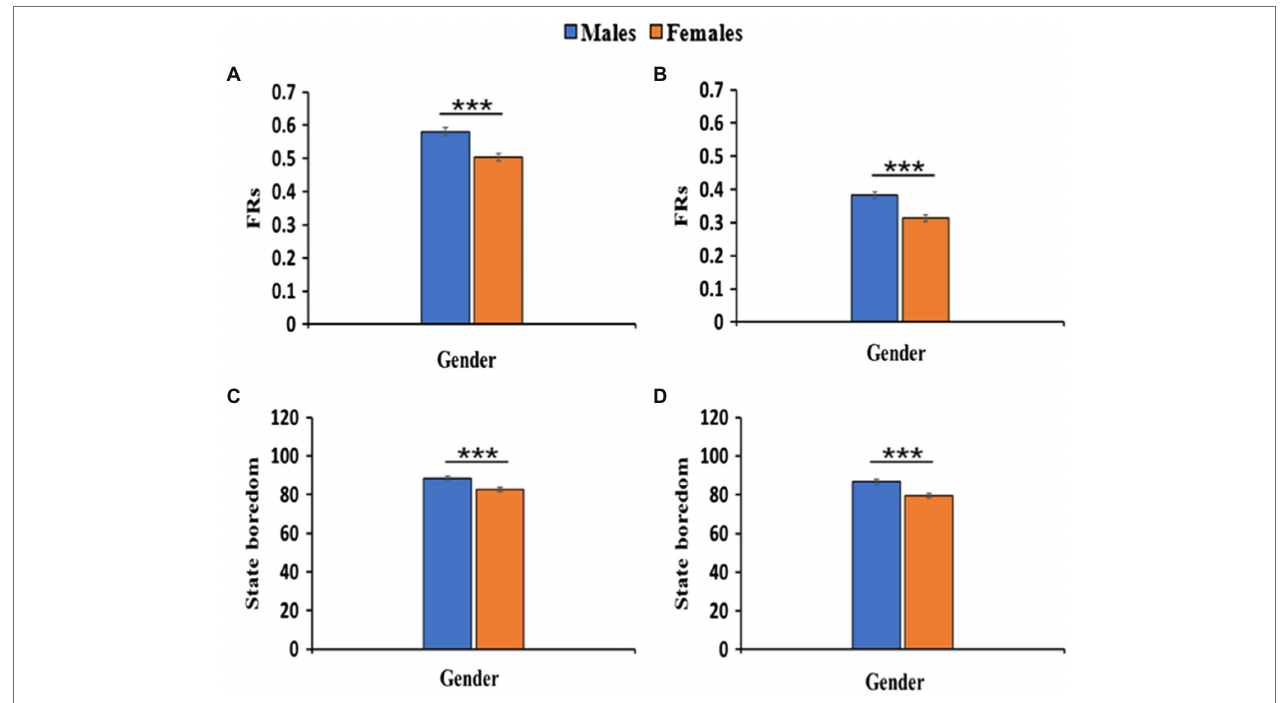
FIGURE 2 | Gender differences for FRs (A,B) , scores of state boredom (C,D) . *** p < 0.001.